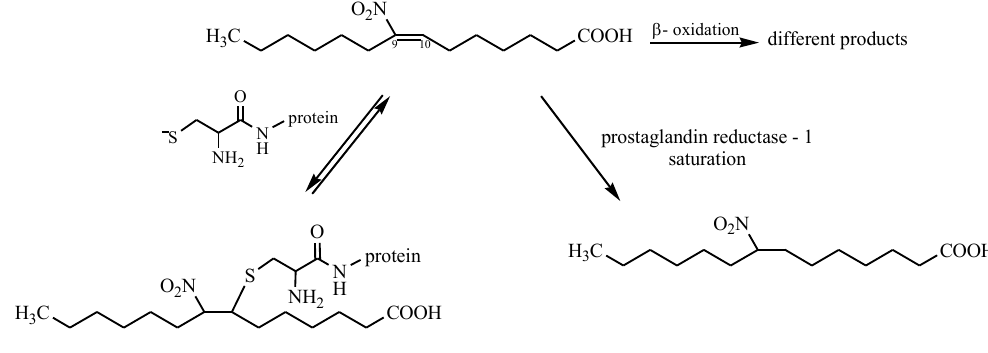
Scheme 7. Mechanism of action of nitro-fatty acids.